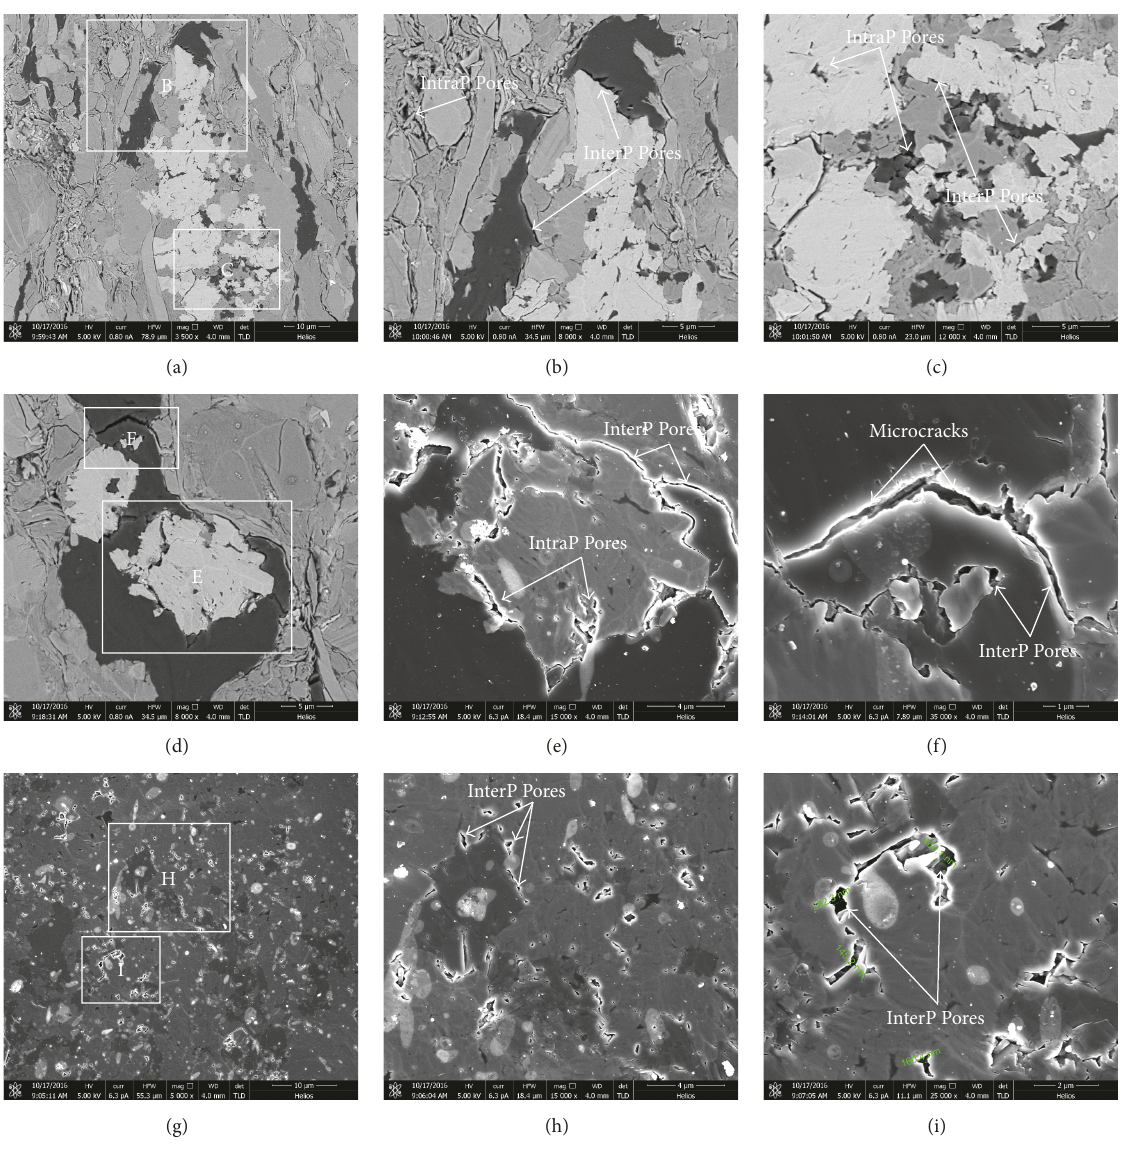
Figure 5: The FIB-SEM images of sample NT-Y3 ( 𝜑